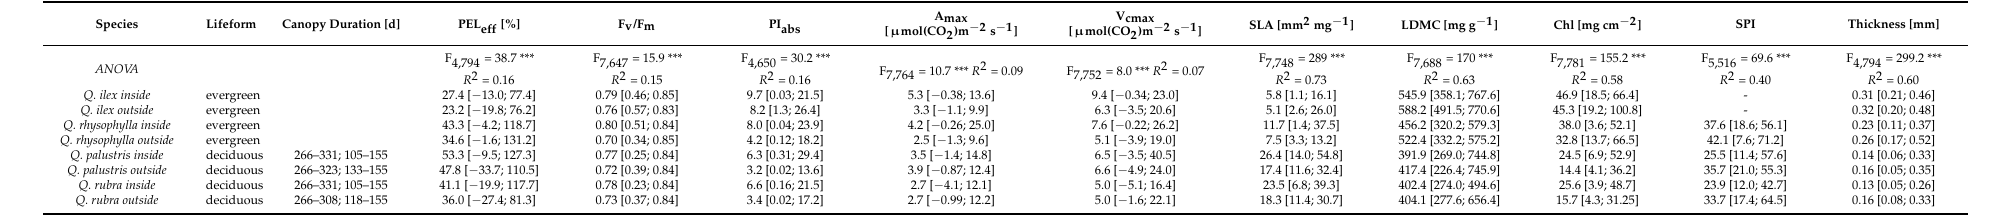
Table 1. Characterisation of four woody species with respect to their mean and range in measured trait values. Given is the mean value for each species as well as the range, i.e., minimum and maximum values measured, of frost resistance measured as effective percentage of electrolyte leakage (PEL eff ), net photosynthetic rate at saturating irradiance and ambient atmospheric CO 2 concentrations (A max ), maximum carboxylation rate (V cmax ), maximum quantum yield of PSII (F v /F m ), absorption-based performance index (PI abs ), specific leaf area (SLA), leaf dry matter content (LDMC), stomatal pore area index (SPI), chlorophyll content (Chl) and leaf thickness (Thickness). The canopy duration indicates, during which period leaves were displayed on deciduous species. Significance is indicated as ‘***’: p <